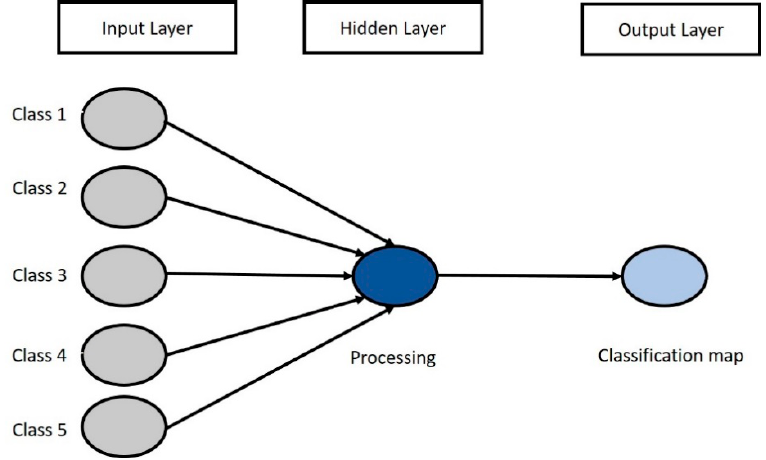
Figure 6. The artificial neural network model used to generate the classification map. Classes 1–5 are the input layers from satellite images, which were selected using ENVI software.